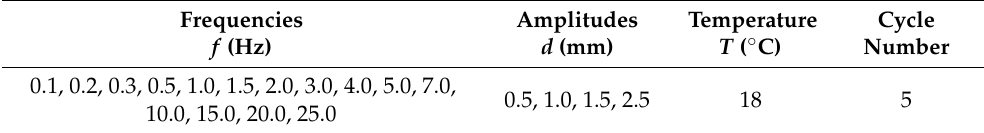
Table 1. Conditions of the dynamic performance